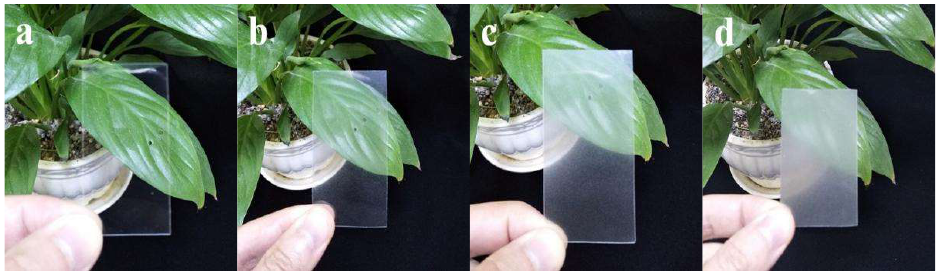
Figure 3. Visual images of PLA/CNF biocomposite films: ( a ) neat PLA; ( b ) PLA/CNF-1.0 wt %; ( c ) PLA/CNF-2.5 wt %; and ( d ) PLA/PLA/CNF-5.0 wt %.